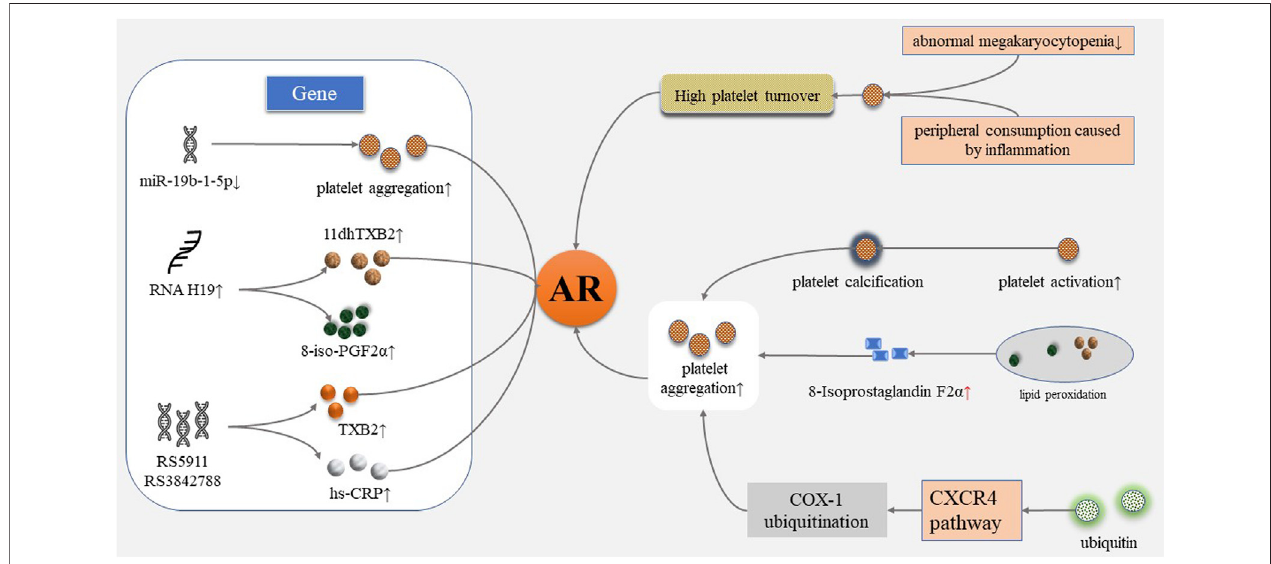
FIGURE 1 | Mechanism of aspirin resistance. AR, aspirin resistance; 11dhTXB2, 11-dehydrogenation thromboxane B2; 8-iso-PGF2 α , 8-iso-prostaglandin F2 α ; hs-CRP, high-sensitivity C-reactive protein; CXCR4, CXC chemokine receptor 4; COX-1, cyclooxygenase-1.